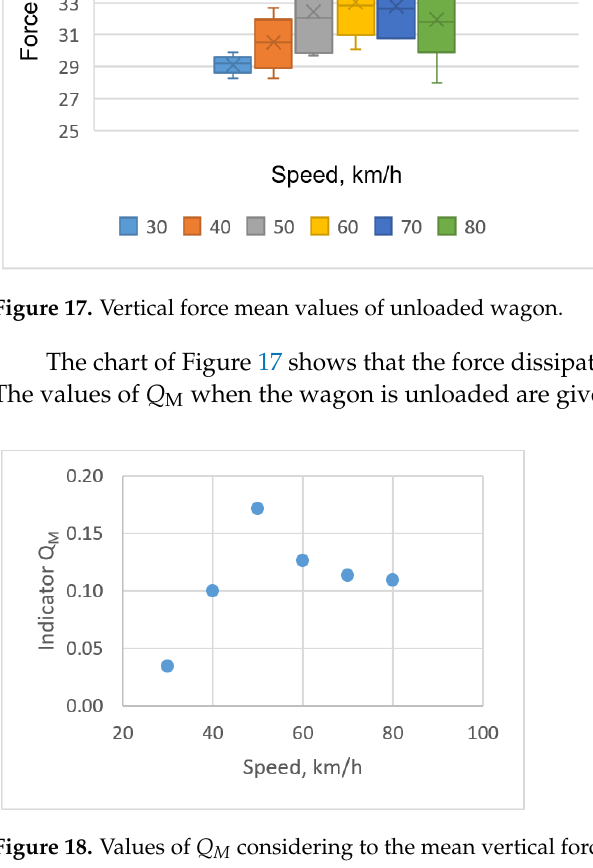
Figure 19. Wheel damage—flat and cracks. Examples of the distribution of vertical forces caused by wheel damage (flat and cracks) in rail cross ‐ sections are provided in the literature [12]. Vertical force maximal values of loaded wagon are given in Figure 20.